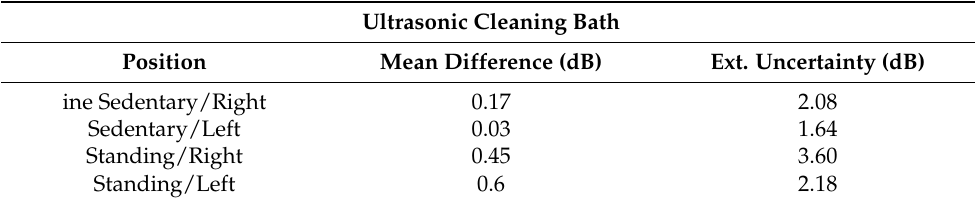
Table 4. Sound fields within the scanning unit when an idealized signal of an ultrasonic cleaning bath was simulated. Results were obtained on the right-hand side of the artificial head in the sedentary position and without the protection grid mounted. The presented plots show the sound fields obtained for: (a) USPM; (b) HiFUSPEx; and (c) difference between the HiFUSPEx and the